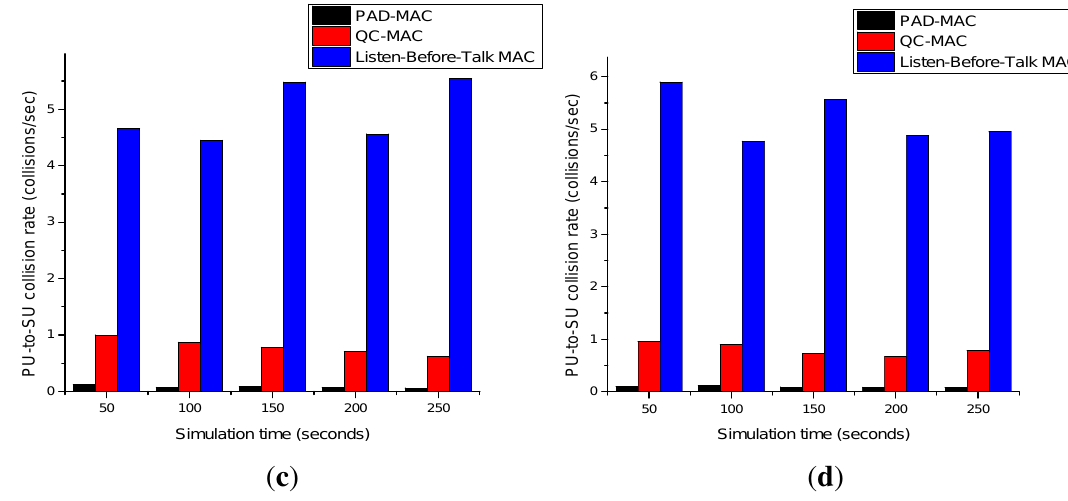
Figure 14. PU collision rate. ( a ) Three channels; ( b ) five channels; ( c ) seven channels; ( d ) ten channels.